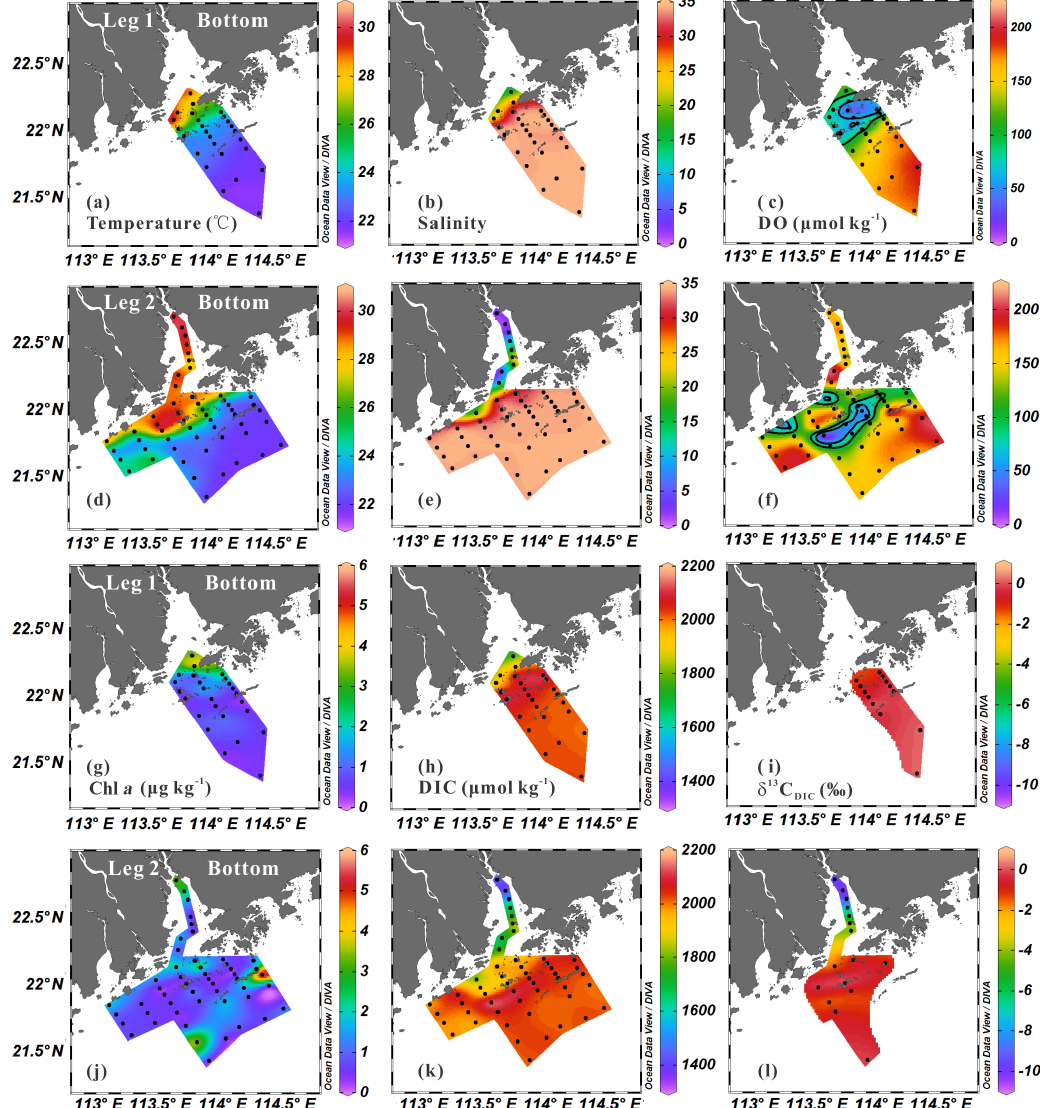
Figure 3. Bottom water distribution of temperature, salinity, DO, Chl a , DIC and δ 13 C DIC during Leg 1 (a–c, g–i) and Leg 2 (d–f, j–l) . Note that the black lines in (c) and (f) indicate DO contours of 63 and